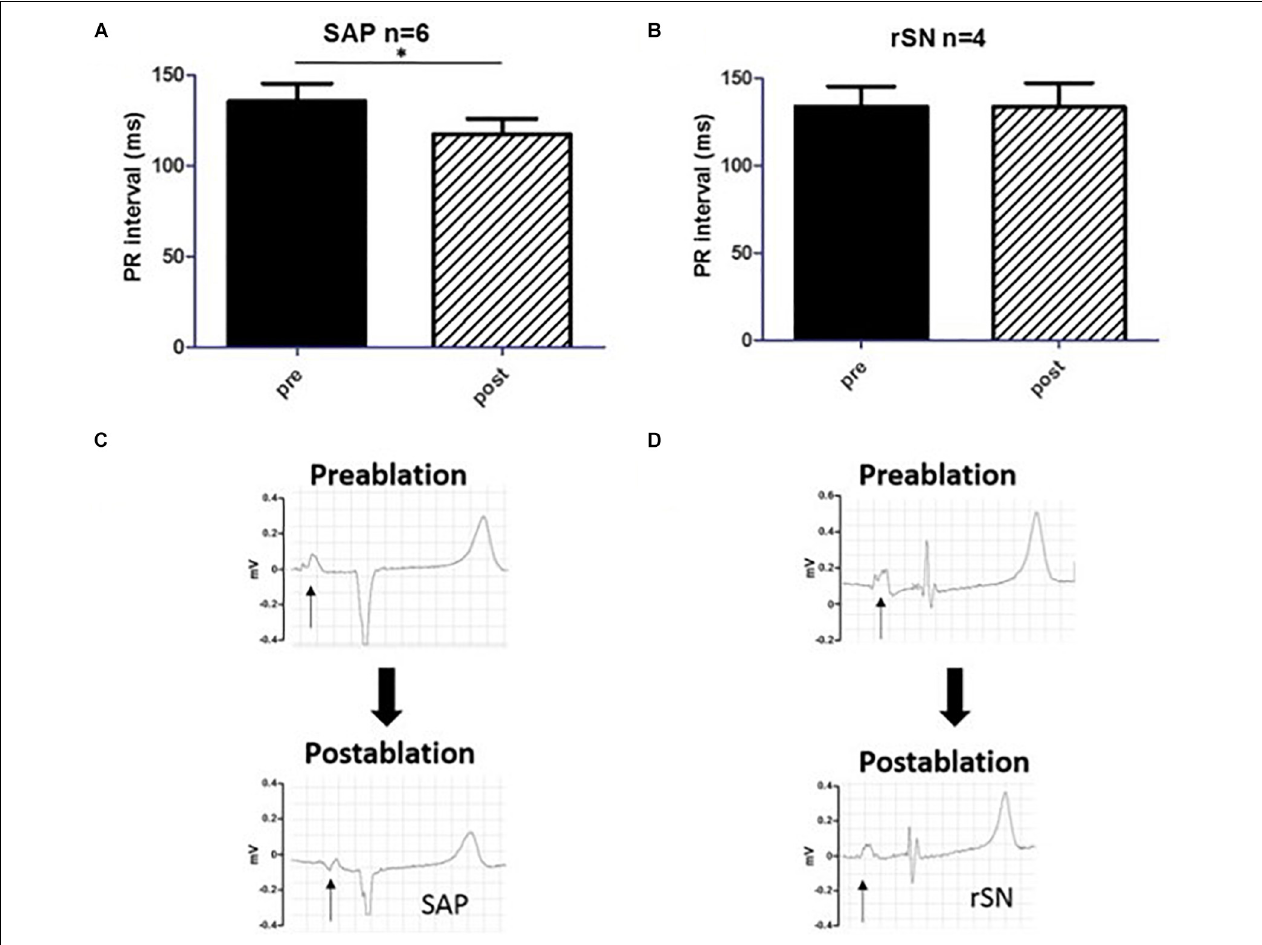
FIGURE 6 | PR-interval and P-wave morphology. (A,B) The comparison of PR-intervals pre and post the ablation procedure, respectively. (A) The PR-interval shortened significantly in the subsidiary atrial pacemaker (SAP) group (pre vs. post, p < 0.05, n = 6). (B) By contrast, no difference was detectable among the experimental animals [recovered sinus node (rSN), n = 4] in which ablation was not successful. (C,D) P-wave morphology change before and after the ablation procedure in SAP and rSN goats, respectively. (C) Surface electrocardiogram (ECG) shows a significant inversion of the first portion of the P-wave (arrow) post-ablation in the SAP. (D) No such shift and P-wave morphology change are observed in rSN goats. * P <